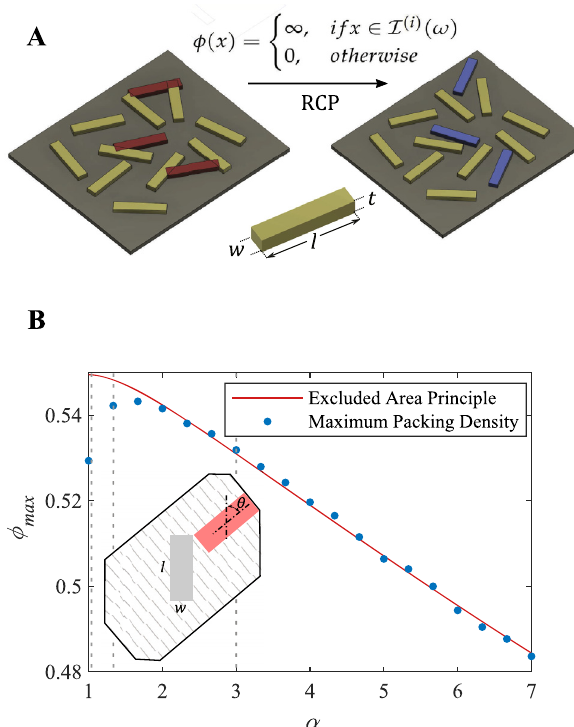
Figure 1: Random close packing of hard rectangles: (A)illustrationofthecollectiverearrangementpackingprotocolwith ϕ ( x ) as the interaction potential and I ( i ) ( ω ) is the indicator function ofphase i inrealization ω and(B)isthecomputedmaximumpacking ) as a function of the aspect ratios ( α ) . The blue dots density ( ϕ max representthesimulateddata,andtheredcurveisa fi ttinglinebased on the excluded area principle given by Eq. (1) with c 1 = 0.047 and c 2 = 1.725. The inset illustrates the excluded area of a rectangle of length l and width w with another identical rectangle with a relative tilt θ